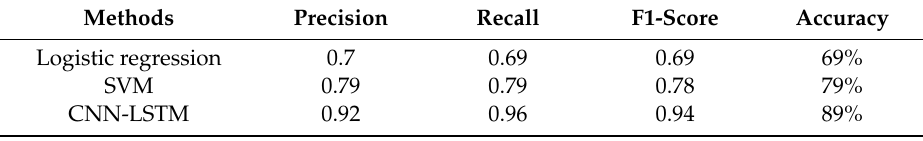
Table 3. Comparison among LR, Support Vector Machines (SVM), and CNN-LSTM models.